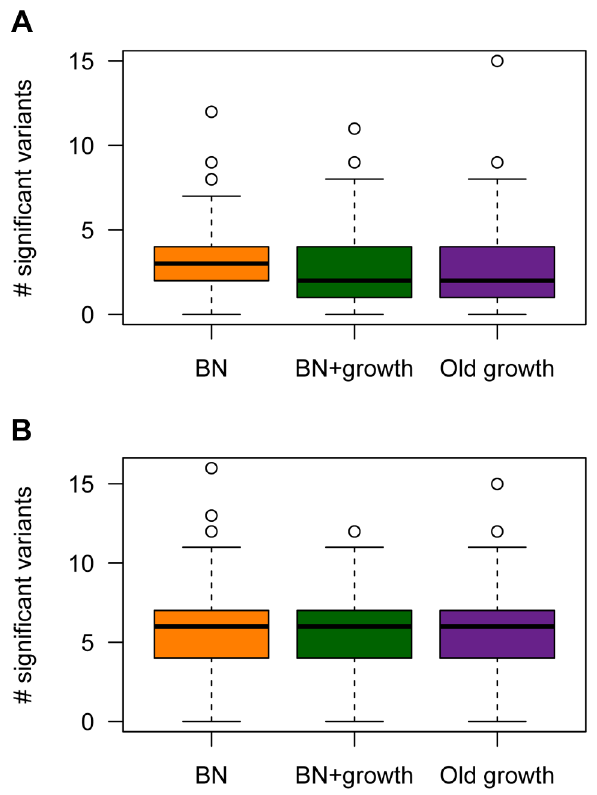
Figure 7. The number of causal SNPs with a significant P -value ( , 1 6 10 2 5 ) in the single-marker association test for different models of population history. ( A ) A SNP’s effect on the trait is correlated with its effect on fitness ( t =0.5). ( B ) A SNP’s effect on the trait is independent of its effect on fitness ( t =0). Here h 2 M =70